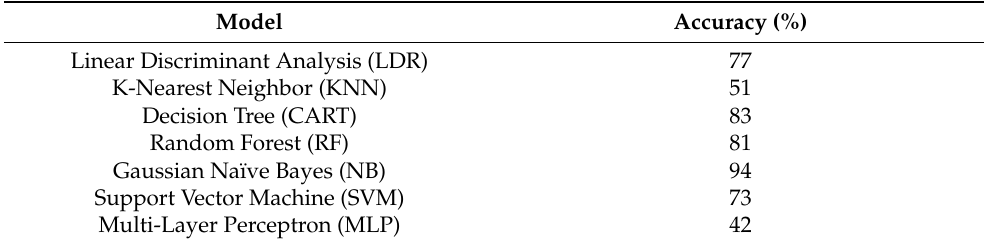
Figure 9. PV dataset with missing samples. Table 6. Accuracy of fault prediction for different ML models using a missing dataset.